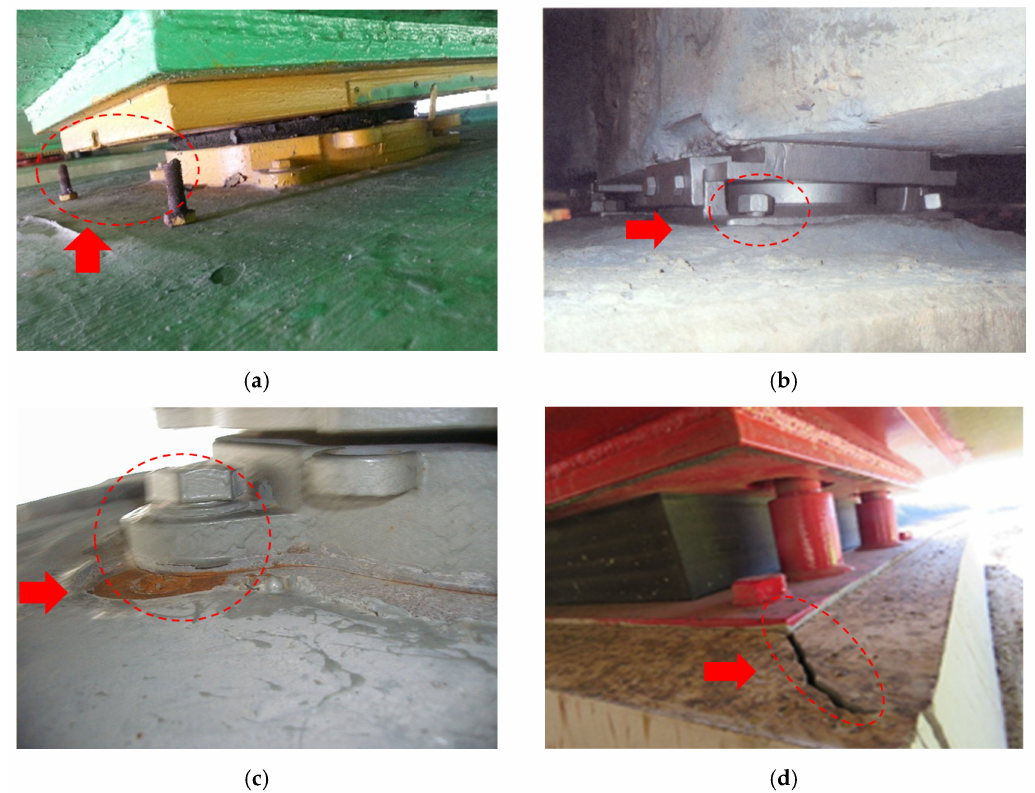
Figure 1. Defects occurring in bridge bearings due to the insu ffi cient embedment depth of anchor bolts: ( a ) rupture of anchor bolt; ( b ) loosening of anchor bolt; ( c ) damage of anchor bolt; ( d ) cracking of bridge bearing pedestal